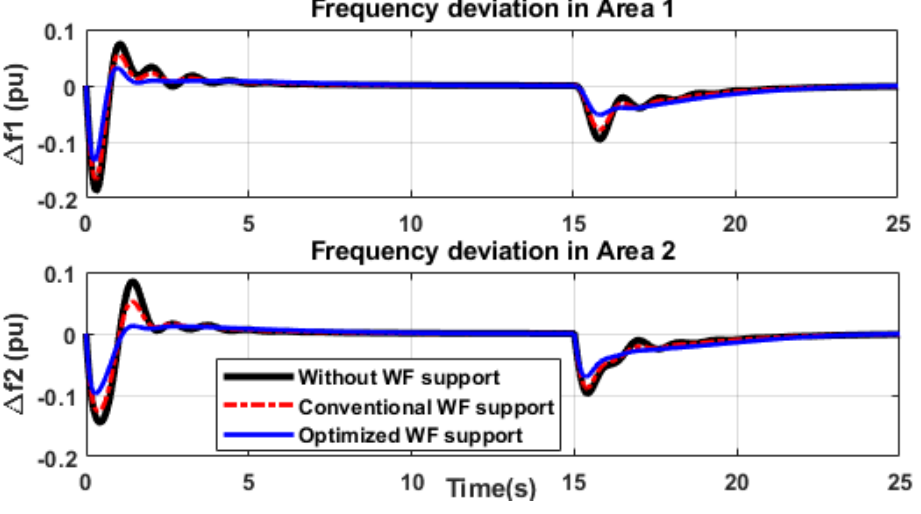
Figure 17. Frequency deviation in contract